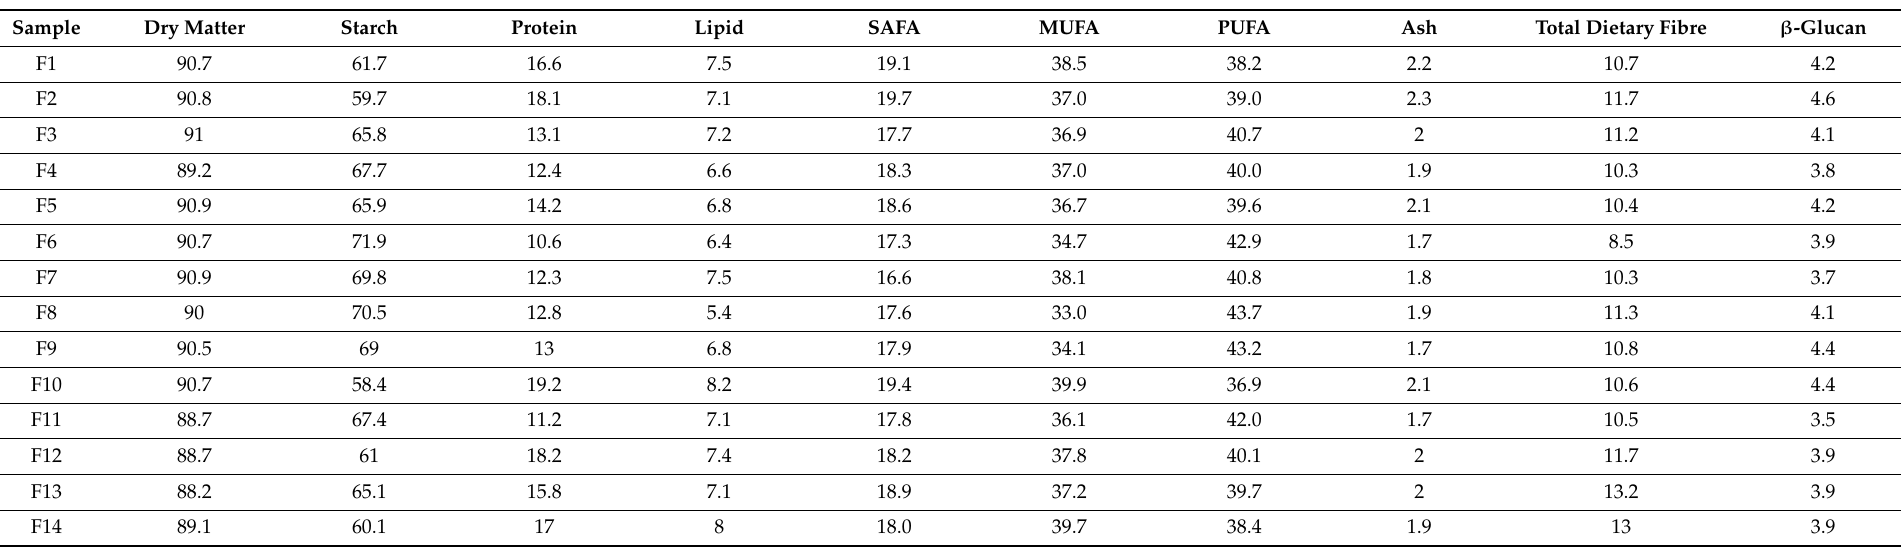
Table A4. Chemical composition of 30 heated oat flours. The starch, protein, fat, ash, total dietary fibre and β -glucan results are presented on a dry matter basis (%). SAFA, MUFA and PUFA are presented as shares of the total fatty acids